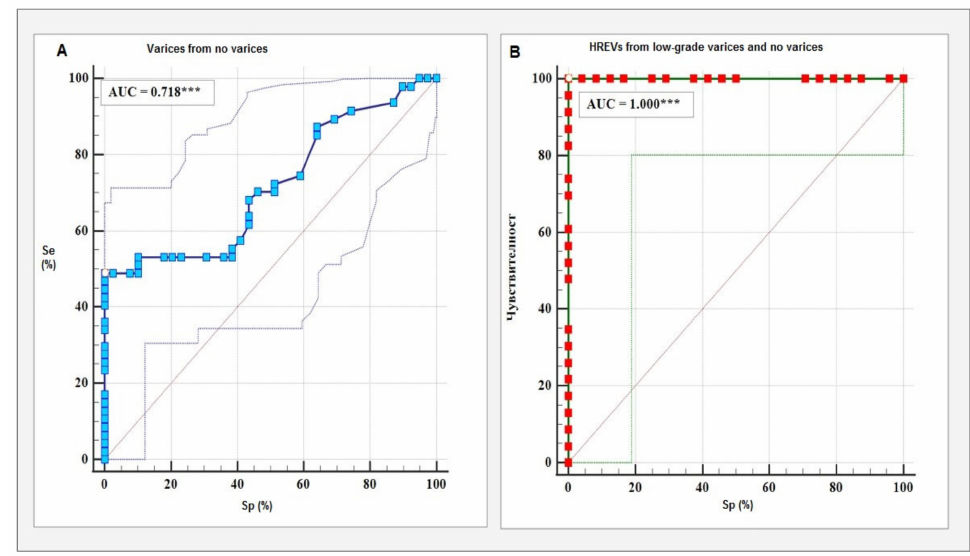
Figure 2. ROC curves of diagnostic accuracy of 2D-SWE; ( A ) Differentiation of patients with EVs from those with no varices, ( B ) Differentiation of grade 4 varices from no varices and EVs grades 1, 2, and 3. Se—sensititity; Sp—specificity; ***—Statistical significance at p ≤ 0.001. A similar comparative analysis was performed between patients with ascites (N = 27) and those without ascites (N = 59). In the group with ascites, a significantly higher value of SWV (2.48 ± 0.31 m/s) was found in comparison with the group without as- cites (2.28 ± 0.23 m/s), p = 0.006. SWV showed a high positive correlation with lab parameters ASAT (r = 0.745, p < 0.001), ALAT (r = 0.753, p < 0.001), and a lower one with AP (r = 0.358, p < 0.001) (Figure 3).